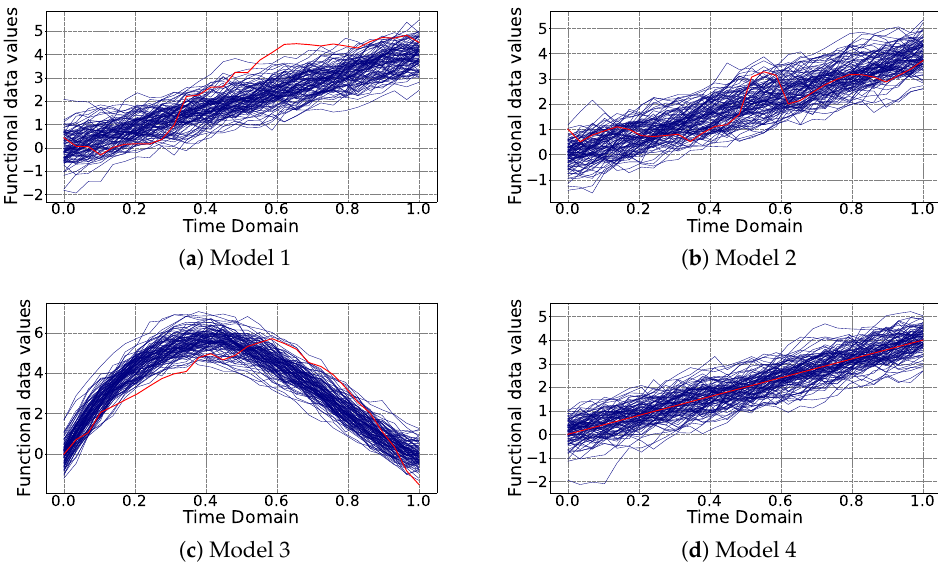
Figure 1. Examples of the four analytical test cases. The blue curves correspond to the 49 ones that are generated from the main model, whereas the red one corresponds to the